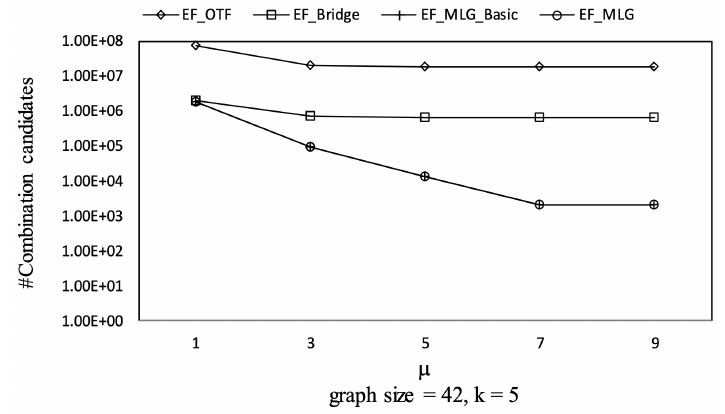
Figure 20. Combination pruning on GraphGen vs. µ with graphsize = 42 and k =